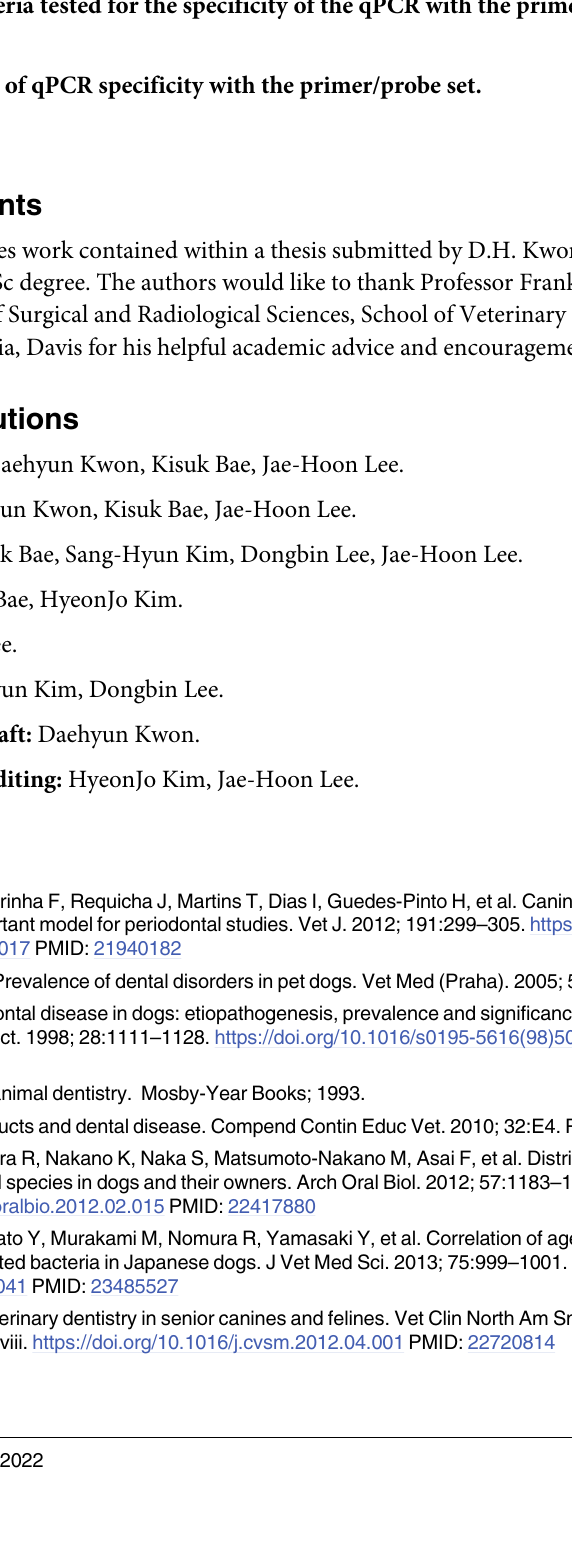
S2 Fig. Standard curves generated from the Ct values for amplification of the target DNA of the red complex bacteria. S1 Table. Primer and probe set used for qPCR detection of 11 bacterial species from the subgingival plaques in the teeth of dogs. S2 Table. List of bacteria tested for the specificity of the qPCR with the primer/probe set. S3 Table. Test results of qPCR specificity with the primer/probe